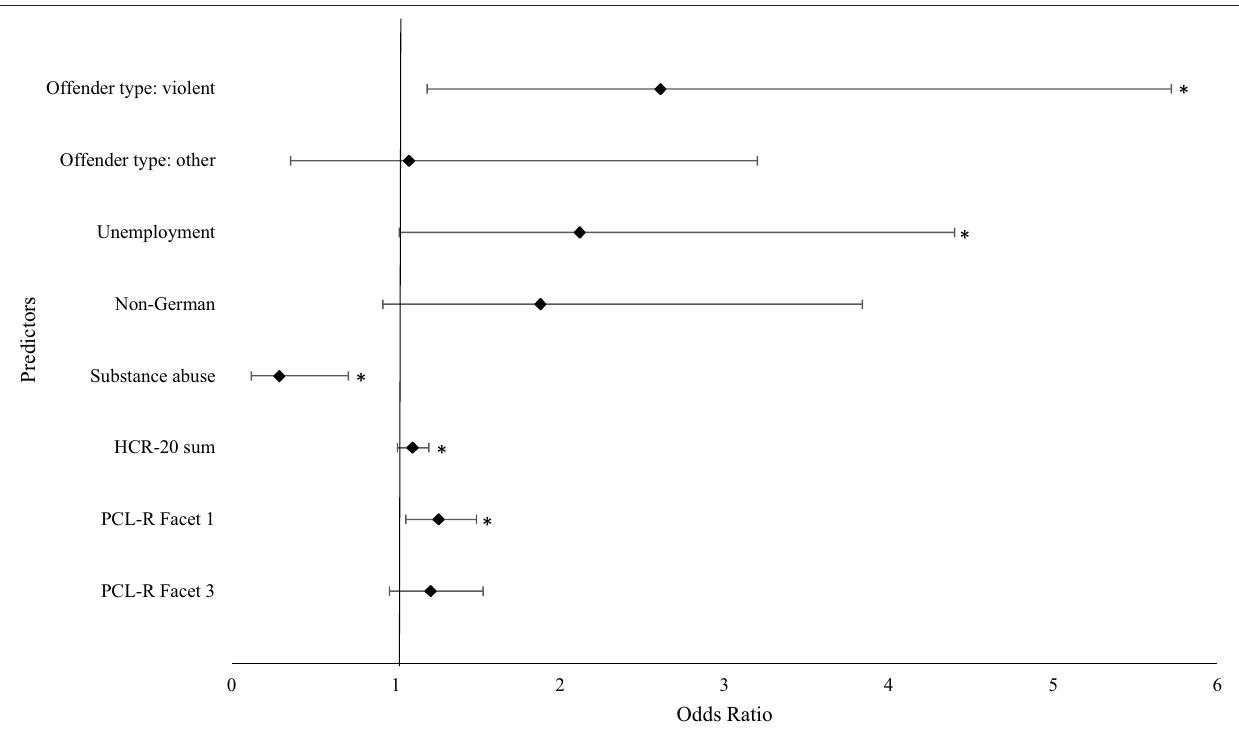
FIGURE 2 | Predictors for the treatment dropout of the model with the best fit. *indicates significance at p ≤ 0.05. CI, confidence interval; HCR-20, Historical Clinical Risk Assessment-20; PCL-R, Psychopathy